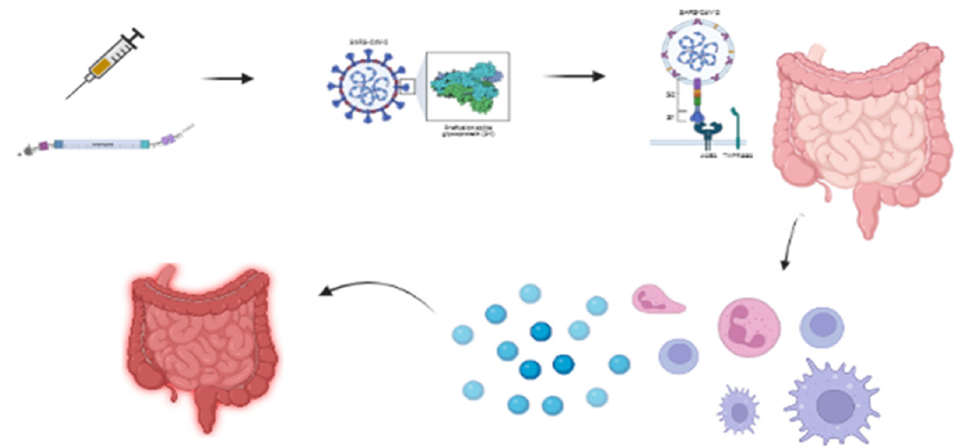
Figure 3. Pathogenetic hypothesis related to COVID-19 post-vaccine adenomesenteritis: The administration of the m-RNA vaccine results in spike protein expression. Spike protein receptors are numerous at the level of enterocytes. The vaccination could act as a trigger and cause an immune-mediated inflammatory response in the gastrointestinal tract resulting in the adenomesenteritis. The figure was created in BioRender.com.